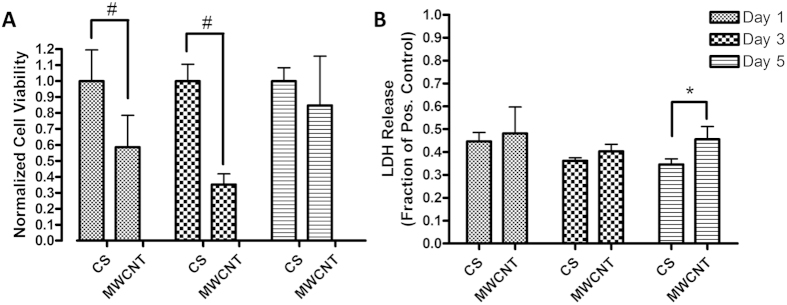
(A) Cell proliferation assessed by MTS assay and (B) cytotoxicity assessed by LDH release for ADSCs 1:4 MWCNT:BP crosslinked substrates (MWCNT) and glass coverslips (CS). Data are presented as mean ± SD (n = 6 per group, #indicates p < 0.001 and *indicates p < 0.01)